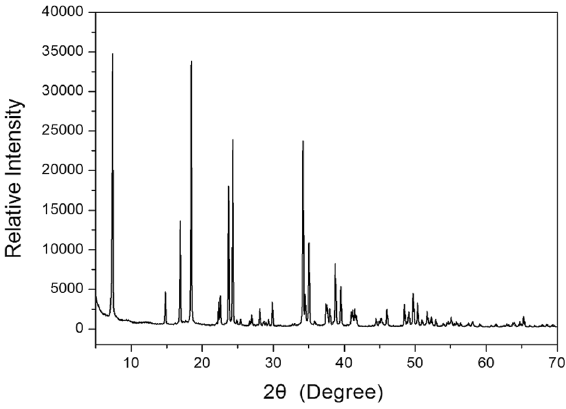
Figure 1. XRD powder pattern of the [NH 3 (CH 2 ) 5 NH 3 ]CdCl 4 crystal at 298